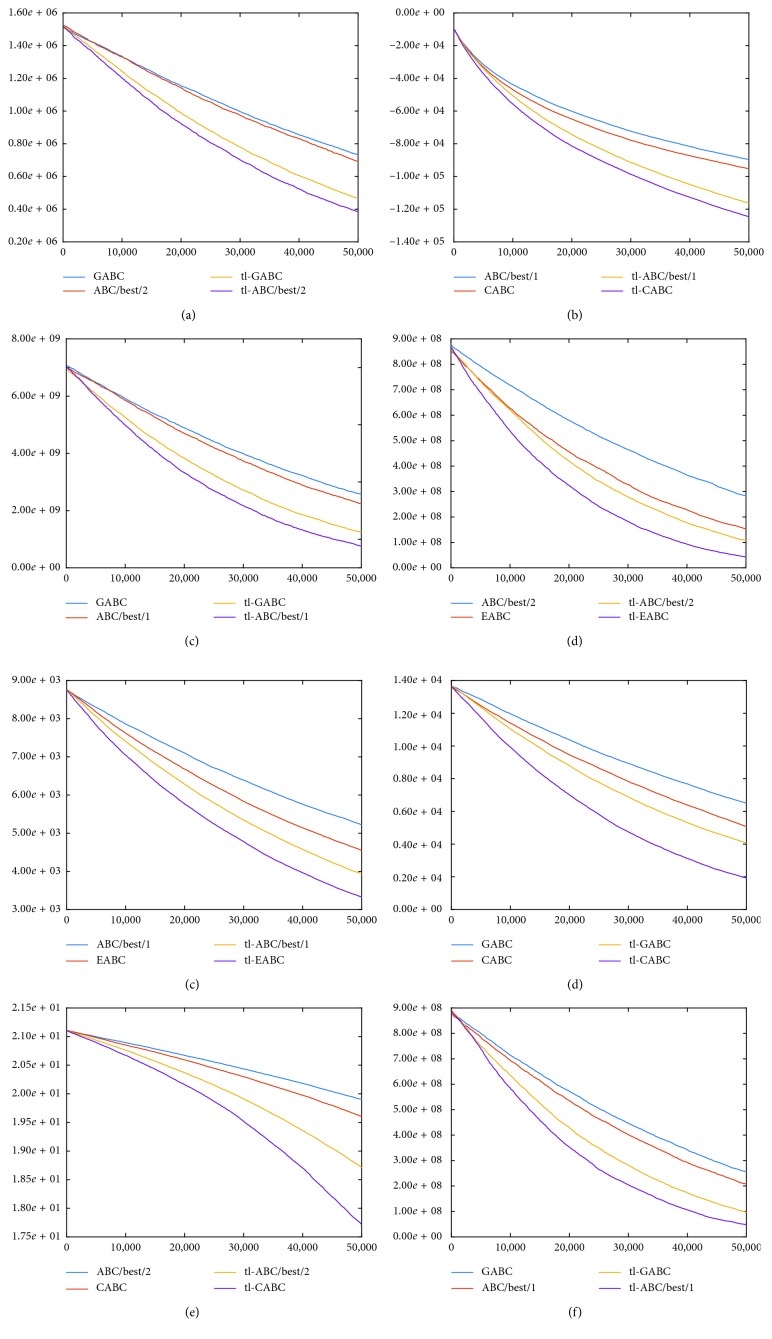
Convergence graphics of 500-dimensional f1 (a), f3 (b), f4 (c), f5 (d), f6 (e), f7 (f), f8 (g), and f9 (h) functions for ABC variants and their tl-based implementations.